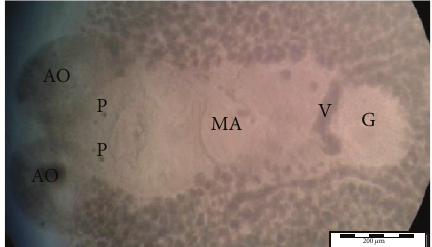
Figure 5: Ventral view of Neobenedenia melleni in compound microscope; AO: anterior attachment organ; P: pigmented eye; MA; male accessory gland reservoir; G: gland of Goto; V: vitelline